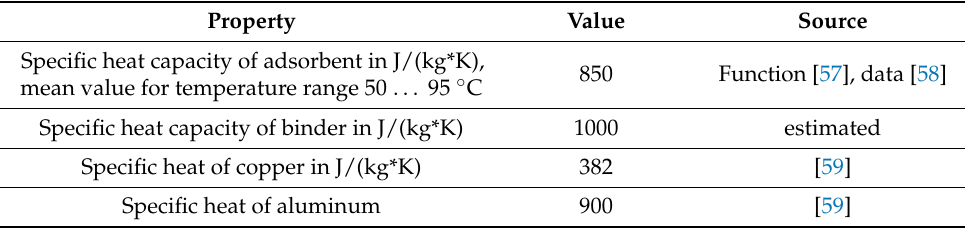
Table 5. Thermo-physical material